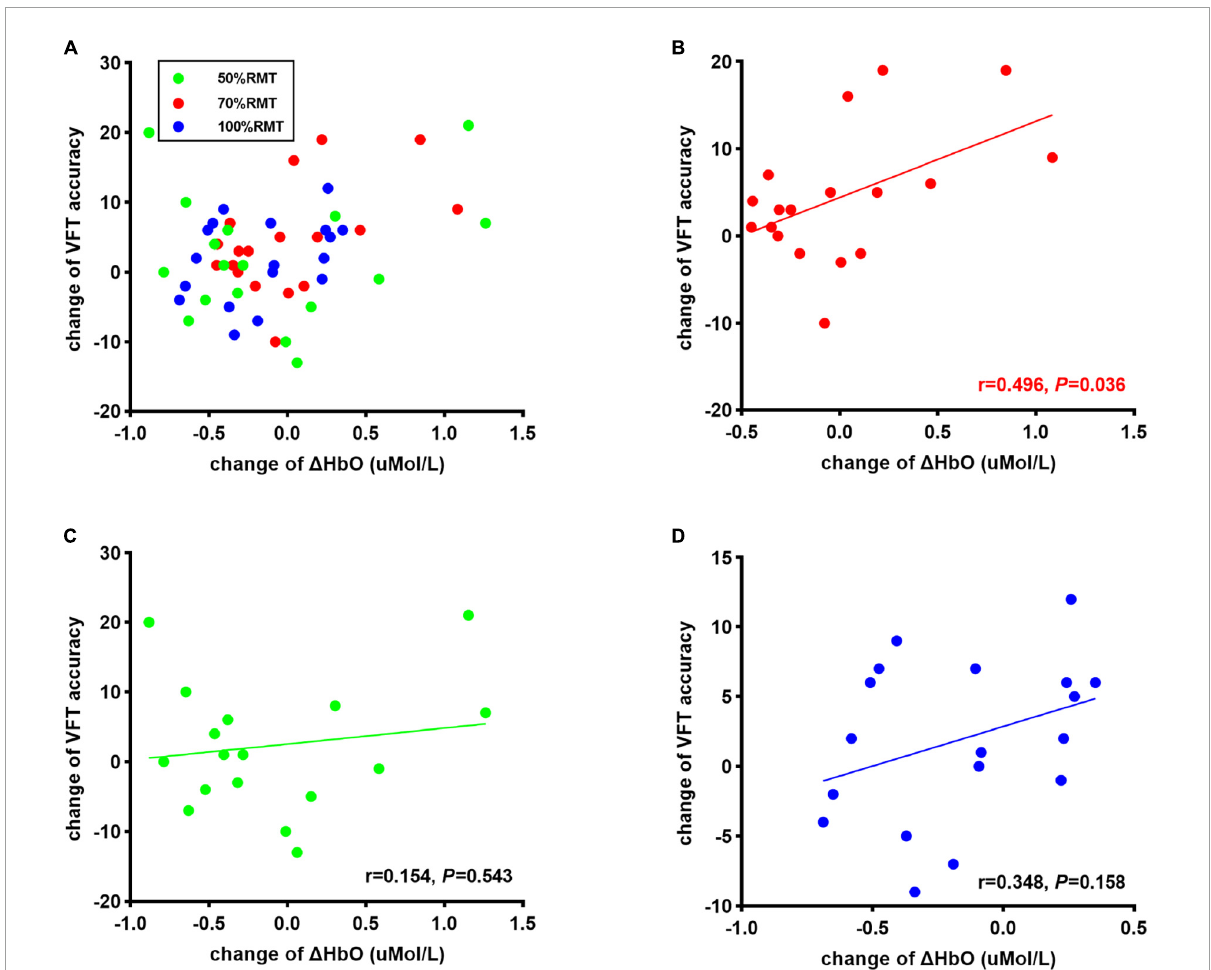
FIGURE5 (A) Correlation between change of corrected words generated during VFT task and change of (cid:49) HbO at all stimulation intensities Correlation between change of corrected words generated during VFT task and change of (cid:49) HbO in 70% RMT stimulation (B) , 50% RMT stimulation condition (C) , and 100% RMT stimulation (D)